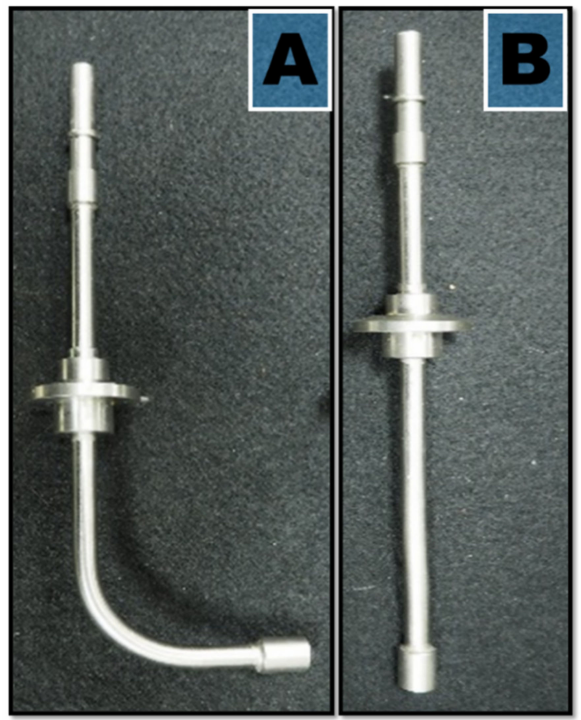
Figure 11. The two urea injector models: ( A ) the original injector from the D6CC diesel engine; ( B ) the suggested urea injector